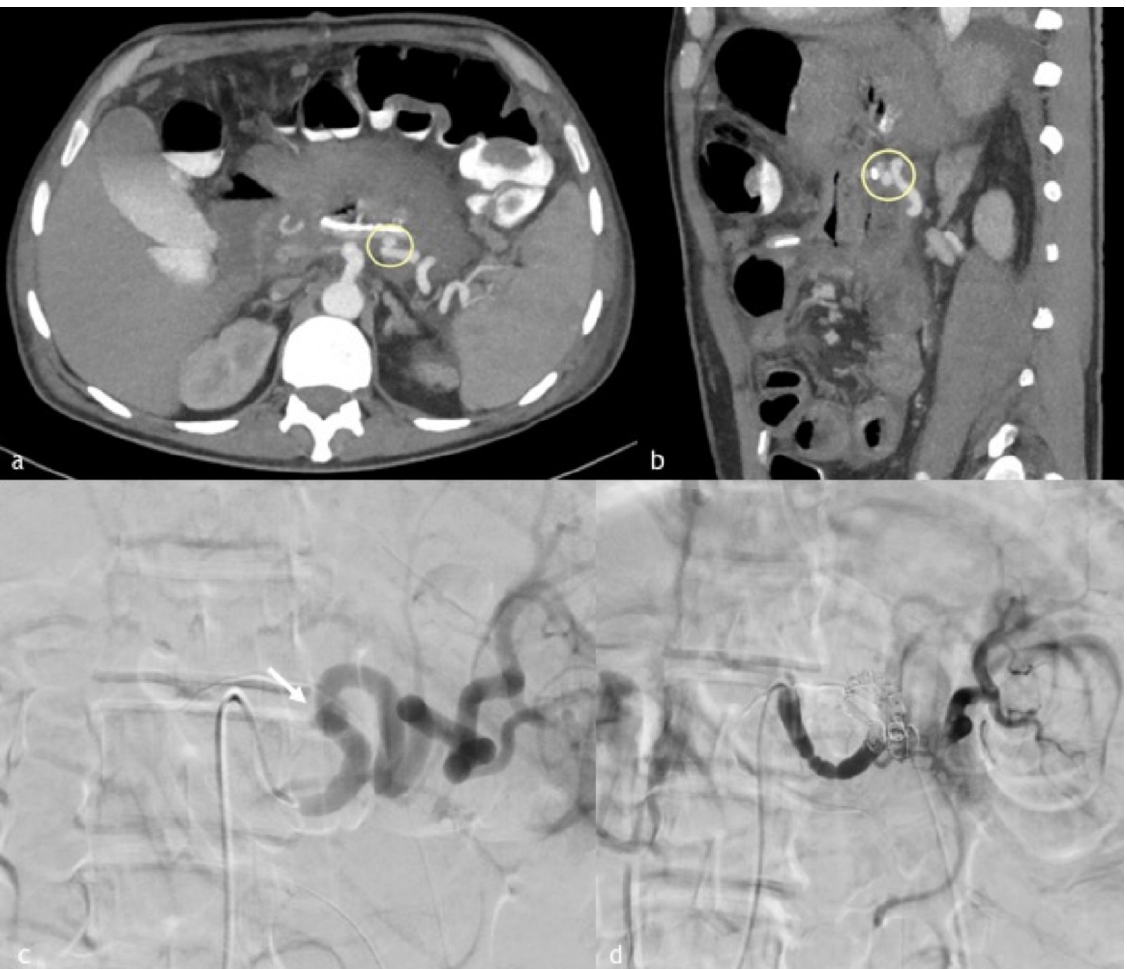
Figure 1. ( a – d ). A 60-year-old man with a walled off necrosis after necrotizing pancreatitis. ( a , b ) Axial and sagittal MPR reconstruction images demonstrate splenic artery PSA (circle) in direct connection with a walled-off necrosis, previously treated surgically. ( c ) Angiographic images of splenic artery PSA (arrow in ( c )). ( d ) Final angiographic control after coil embolization demonstrates splenic artery recanalization distal to coil embolization by magna pancreatic artery.